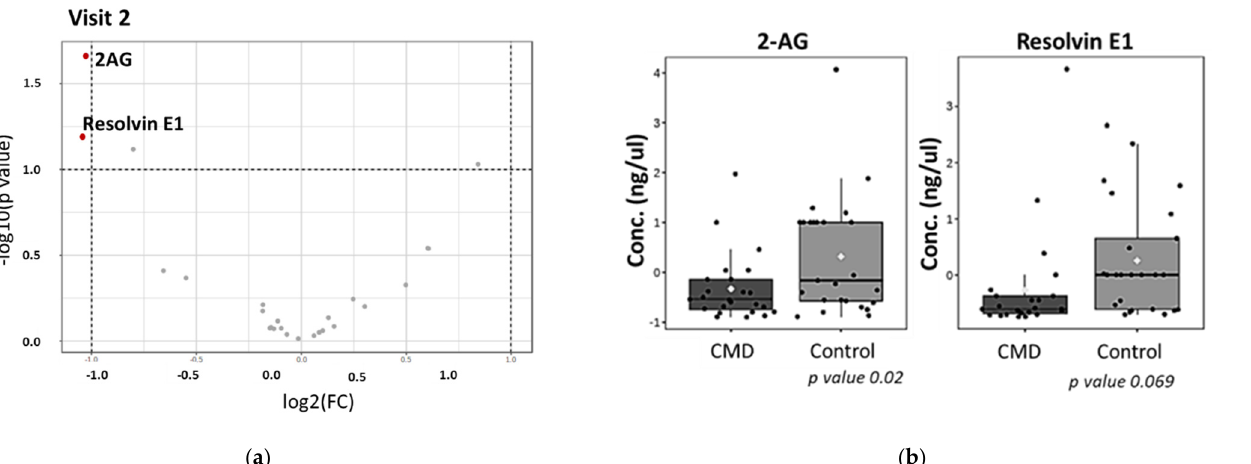
Figure 7. Distribution of oxylipins in late pregnancy. ( a ) Volcano plot demonstrating that there are significant decreases in 2-AG concentrations in the serum of CMD patients compared to control patients. ( b ) There are significant decreases in normalized concentrations of 2-AG in serum of CMD group compared to control group. The abundance of RvE1 appears lower in the serum of CMD patients though is not statistically significant ( p value